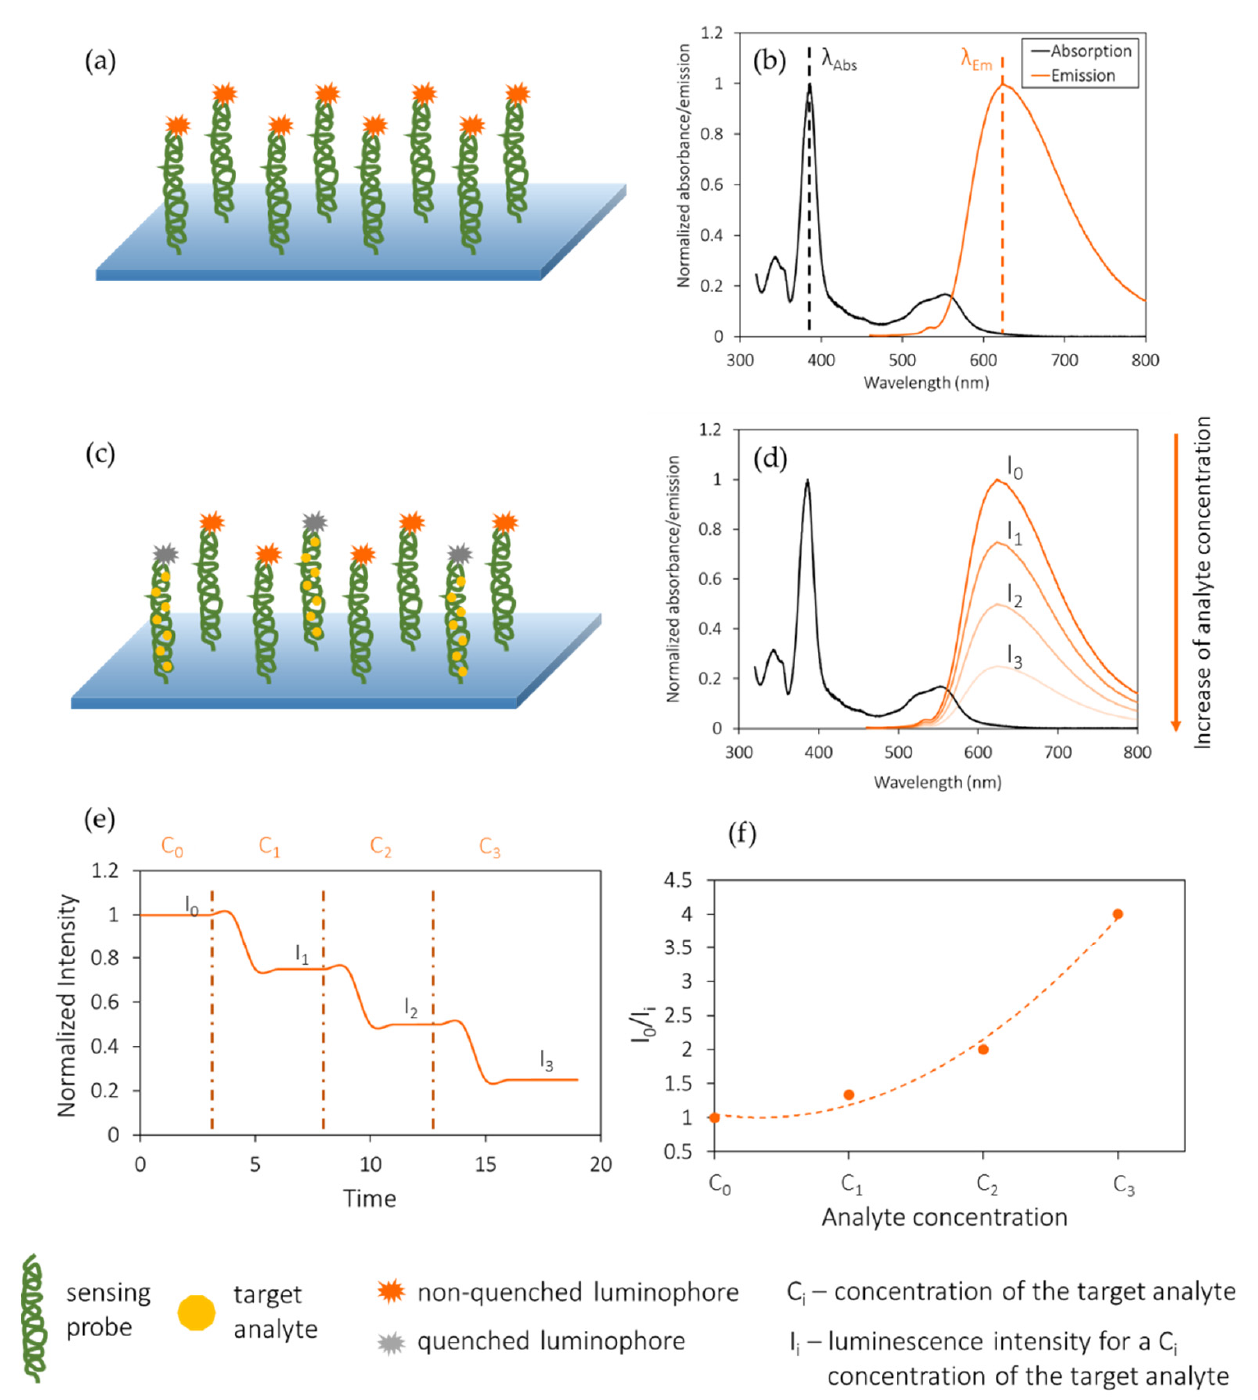
Figure 3. Working principle of a luminescence quenching-based optical fiber biosensor. ( a ) Fiber functionalized with a luminophore-labelled bioreceptor. ( b ) When illuminated at the absorption wavelength of the luminophore, luminescent emission takes place. ( c ) Quenching of the luminophore in the presence of target analyte. ( d ) Decrease in luminescent emission as the target analyte concentration increases. Dynamic response ( e ) and calibration curve ( f ) of the biosensor. The purpose of this schematic is to show the generic behavior of this kind of sensors, so the graphs do not correspond to experimental or simulated data, nor to any existing material.